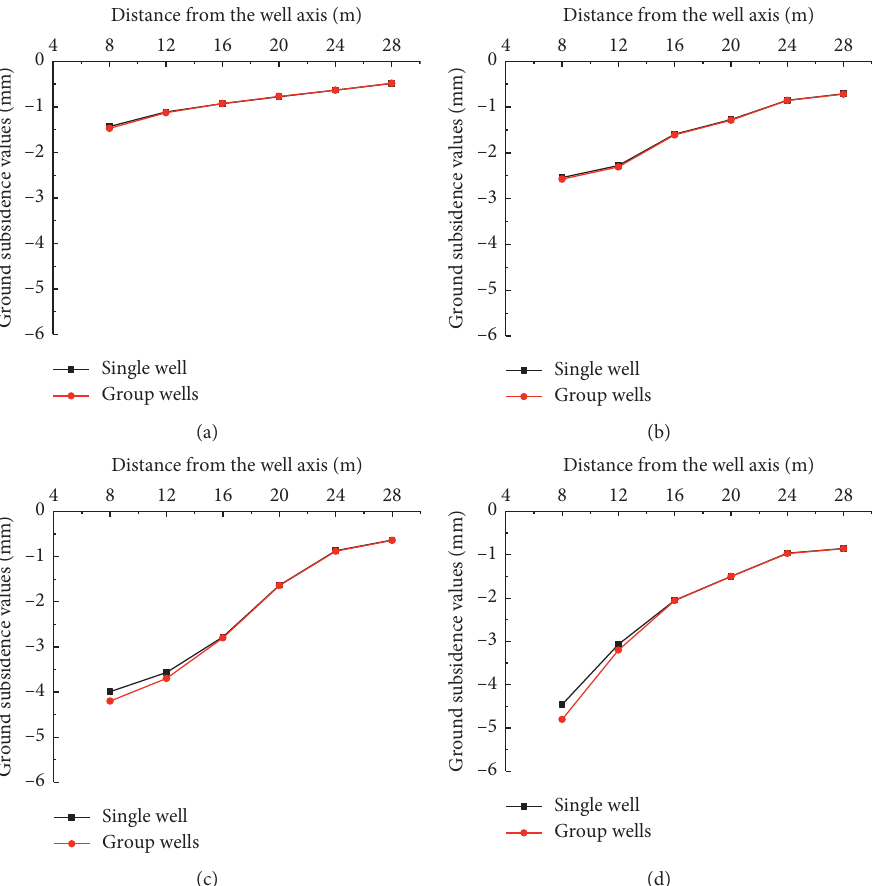
Figure 33: Comparison of ground subsidence around single well and group wells under different drawdowns. (a) Grade I drawdown. (b) Grade II drawdown. (c) Grade III drawdown. (d) Grade IV drawdown (drawdown